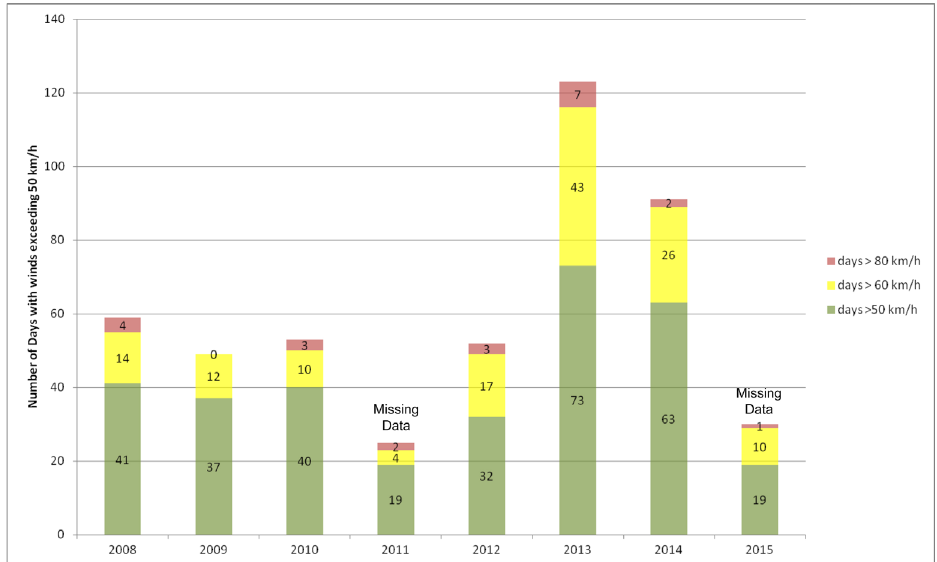
Fig. 11: Chart of high (>50 km/h) wind speed events near